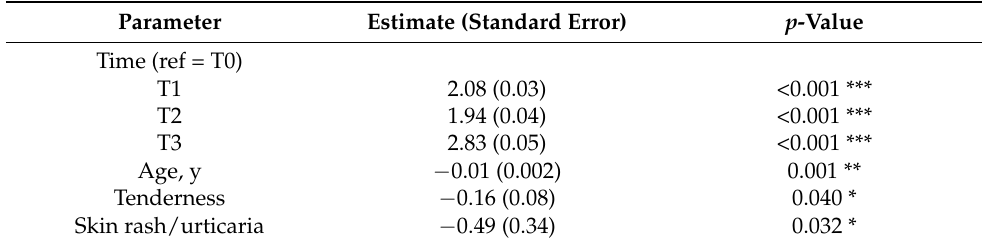
Table 4. Timeframe and adverse events associated with log SARS-CoV-2 RBD IgG levels, adjusted for age, sex, BMI, smoking, drinking, dialysis modality, and comorbidities. Parameter Estimate (Standard Error) p -Value Time (ref = T0) T1 2.08 (0.03) <0.001 *** T2 1.94 (0.04) <0.001 *** T3 2.83 (0.05) <0.001 *** Age, y − 0.01 (0.002) 0.001 ** Tenderness − 0.16 (0.08) 0.040 * Skin rash/urticaria − 0.49 (0.34) 0.032